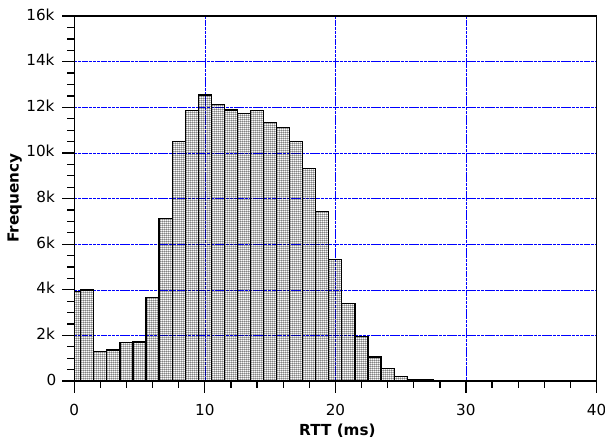
Figure 15. TCP session RTT histogram on router with an unmodified Linux